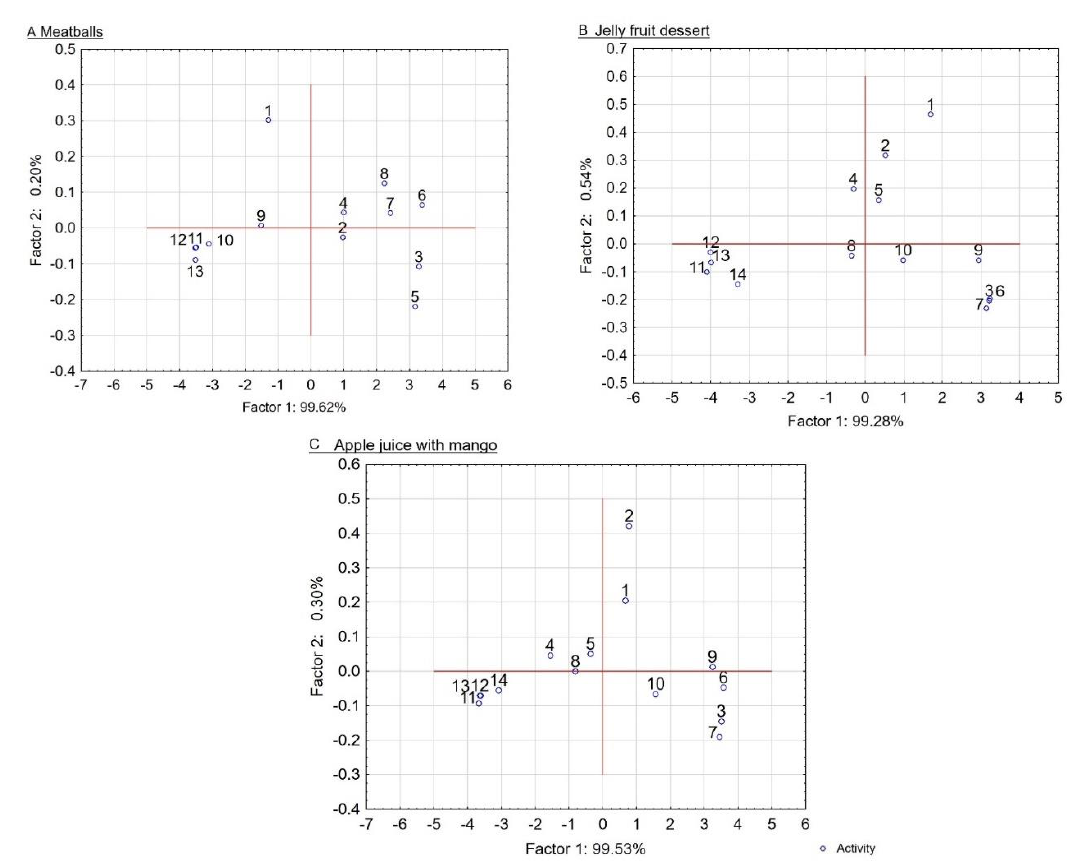
Figure 4. The projection of cases on the factor plane for samples coding for ( A ) Meatballs: 1—meat taste 2—salty taste, 3— bitter taste, 4—fatty taste, 5—powdered taste, 6—metallic taste, 7—red color, 8—gray color, 9—brown color, 10—uniformity of color, 11—taste desirability, 12—color desirability, 13—general desirability; ( B ) Jelly fruit dessert; and ( C ) Apple juice with mango: 1— sour taste, 2—sweet taste, 3—bitter taste, 4—fruit taste, 5—mango taste, 6—powdered taste, 7— metallic taste, 8—yellow color, 9—brown color, 10—clarity of color, 11—uniformity of color, 12—taste desirability, 13— color desirability, 14—general desirability.